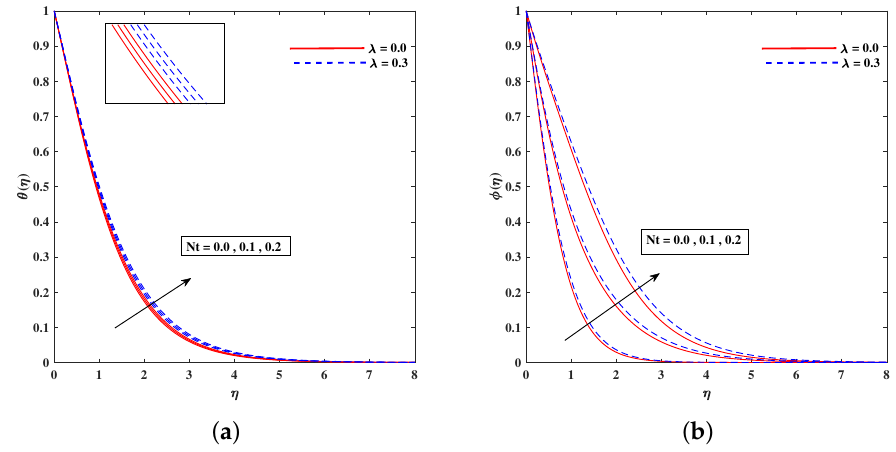
Figure 10. Fluctuation of Nt on temperature ( a ) θ ( η ) and concentration profile ( b ) φ ( η )